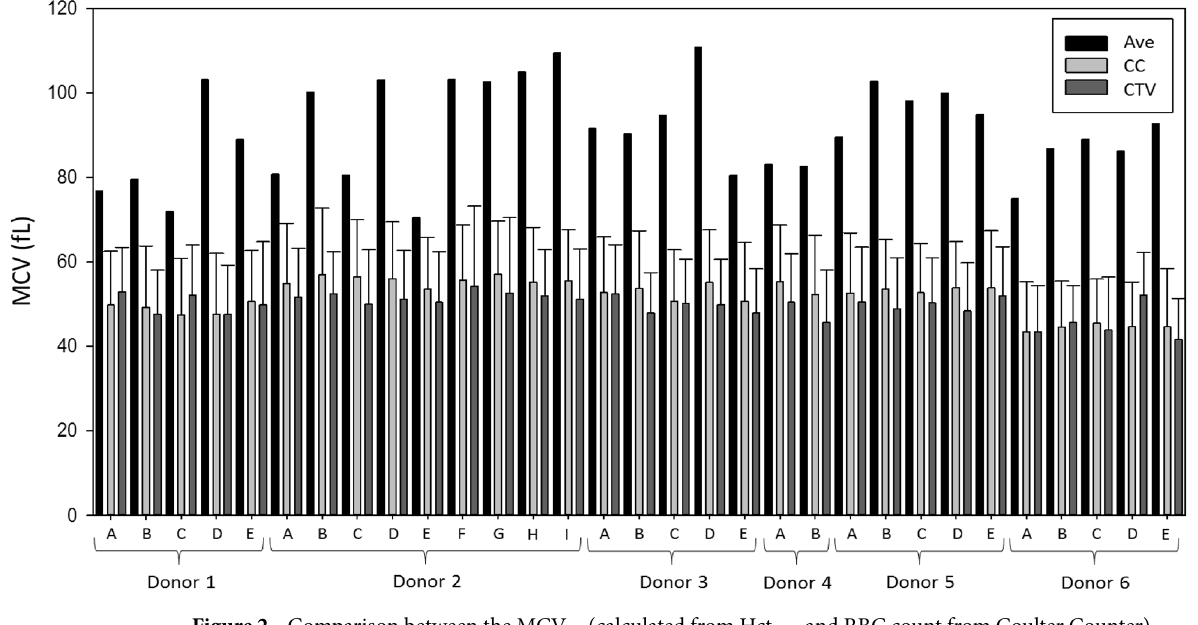
Figure 2. Comparison between the MCV ave (calculated from Hct PCV and RBC count from Coulter Counter), MCV CC (direct measurment from Coulter Counter), and the MCV CTV (calculated from sedimentation rate data) values for all 31 healthy blood samples.